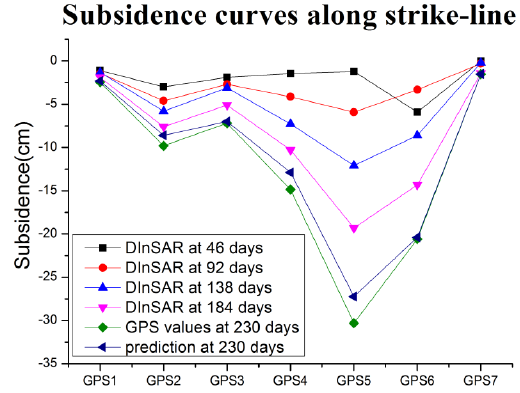
Figure 4. Cumulative subsidence map.